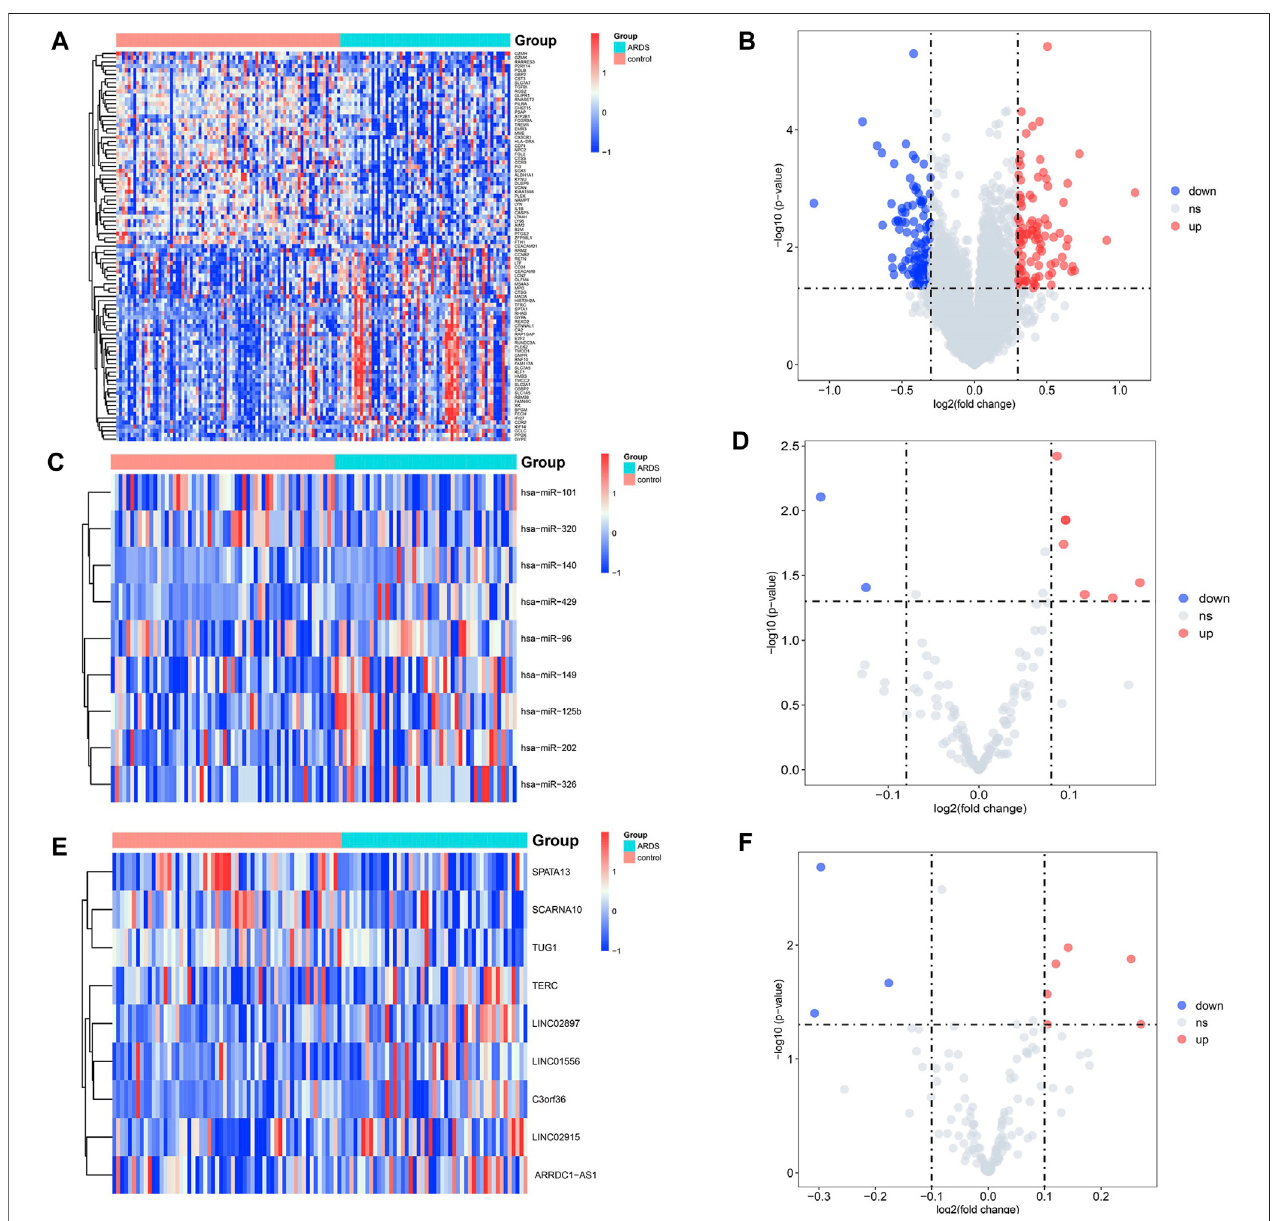
FIGURE 2 | Volcano plots and heatmap of DElncRNAs, DEmiRNAs, and DEmRNAs between the patients with sepsis-induced ARDS and sepsis alone. (A,B) The volcano plots and heatmap for 9 DElncRNAs (|log2FC| > 0.1 and p .value < 0.05). (C,D) The volcano plots and heatmap for 9 DEmiRNAs (|log2FC| > 0.08 and p .value < 0.05). (E,F) Thevolcanoplotsandheatmapforthetop100DEmRNAs(|log2foldchange| > 0.3and p .value < 0.05).Thered dotsrepresenttheupregulatedgenes,and the blue dots represent the downregulated genes.